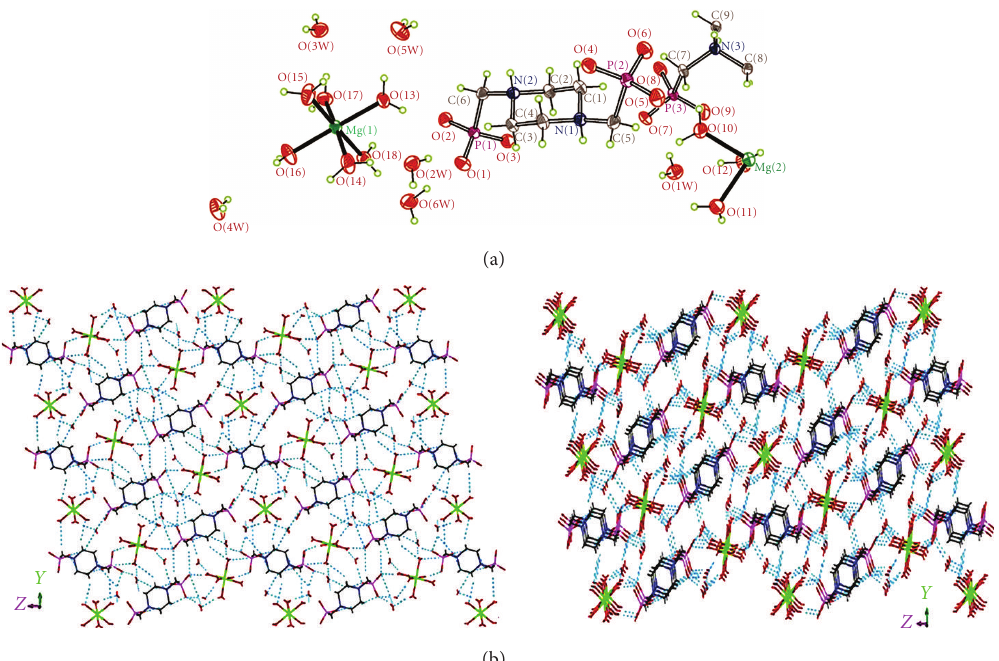
thermal ellipsoids). (b) e 2-D layer in the bc plane and the 3-D %